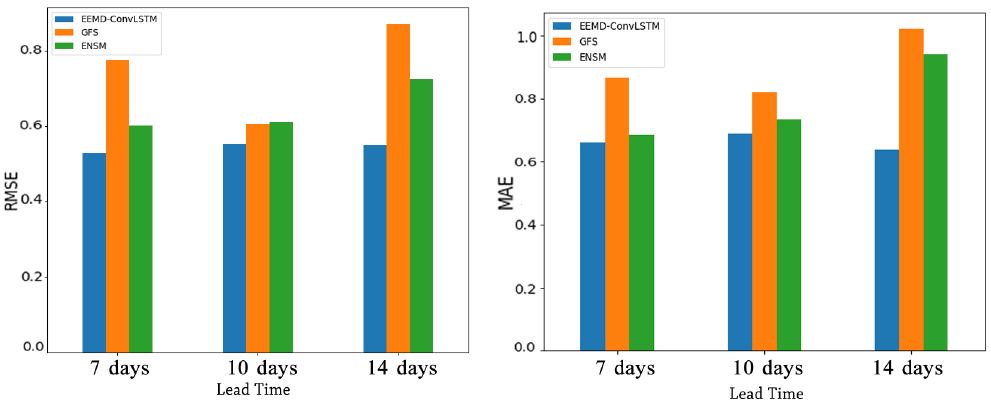
Figure 10. The RMSE and MAE of forecast results with different